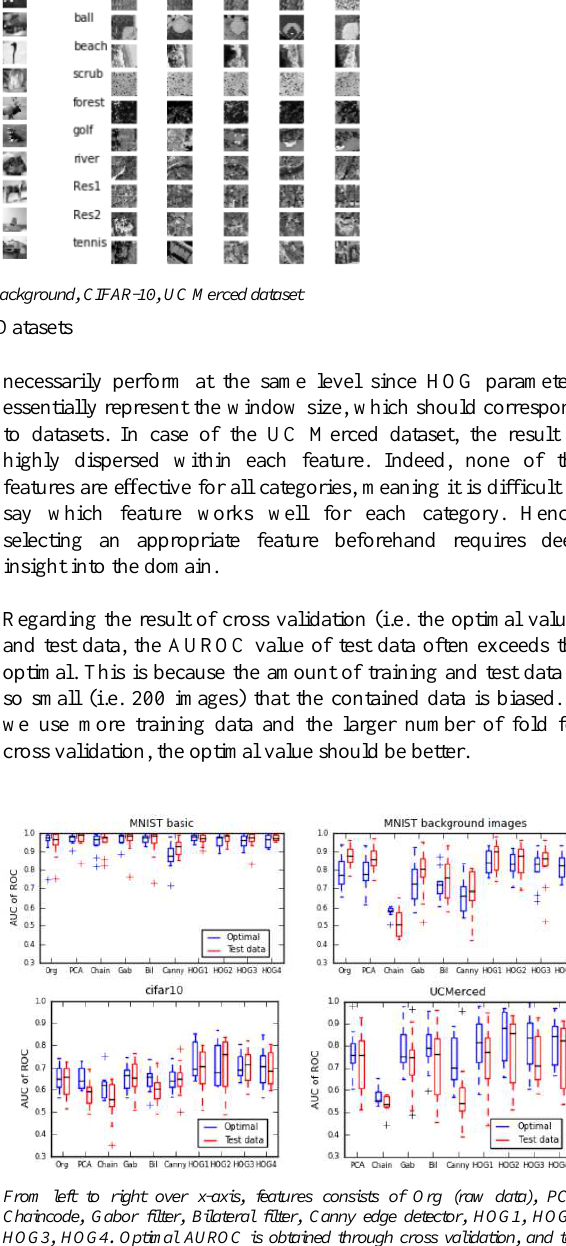
Figure 5. Performance by each features with Config.